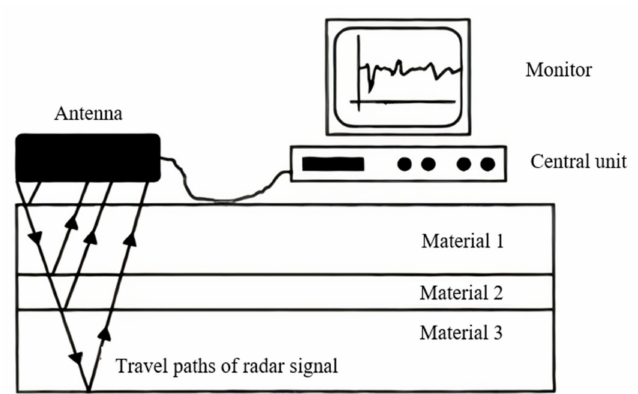
Figure 13. The basic configuration of ground-penetrating radar